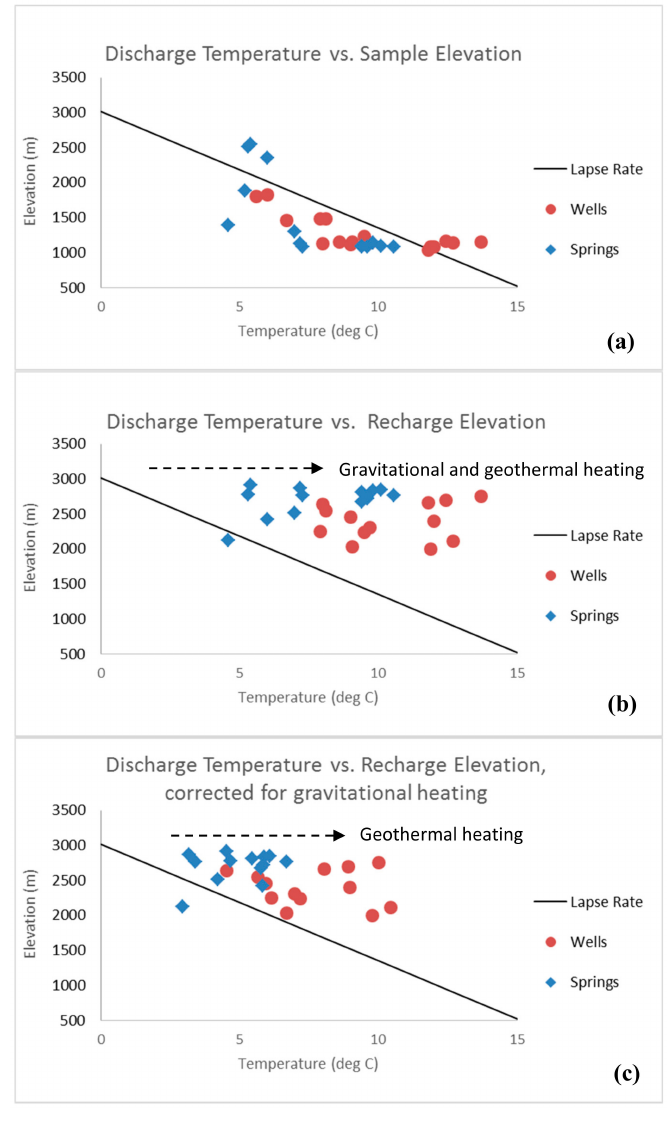
Figure 7. Discharge temperatures are plotted against sample elevation ( a ) and δ 18 O recharge elevation ( b ). The arrow indicates the increase in temperature between recharge and discharge which is attributed to gravitational energy accumulated along flow paths and geothermal heating. Discharge temperatures corrected for gravitational heating plotted against recharge elevation show the residual geothermal heating ( c ). Black lines show the expected lapse rate of temperature vs.